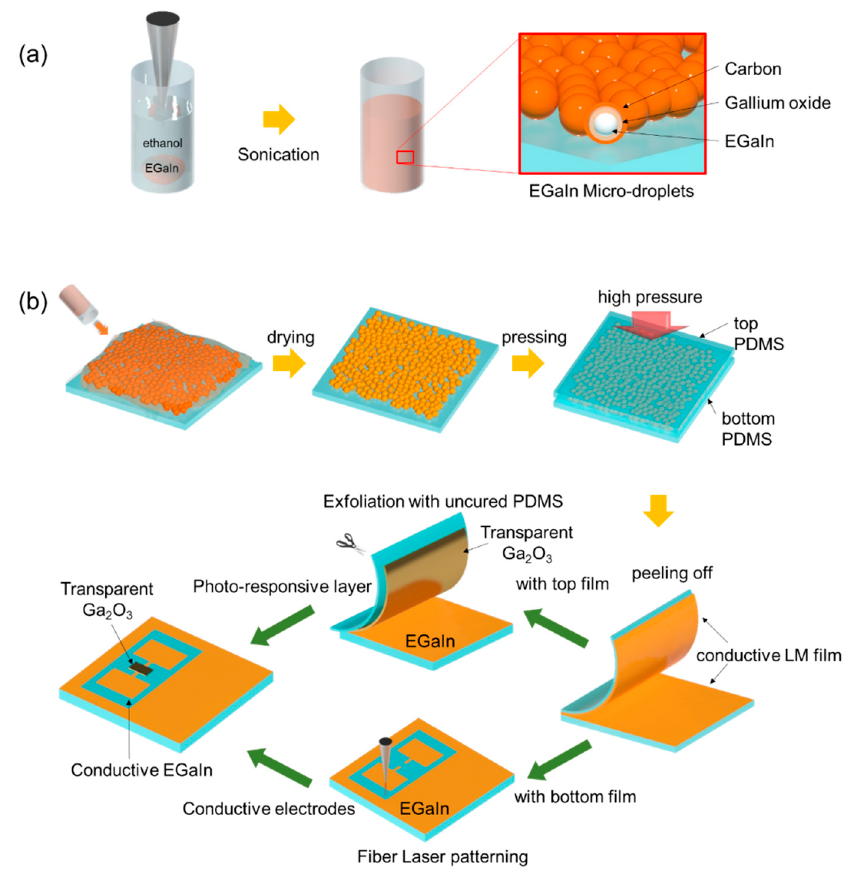
Figure 1. ( a ) Preparation process of EGaIn microdroplets; ( b ) Illustration of the fabrication process of a flexible and transparent photodetector.